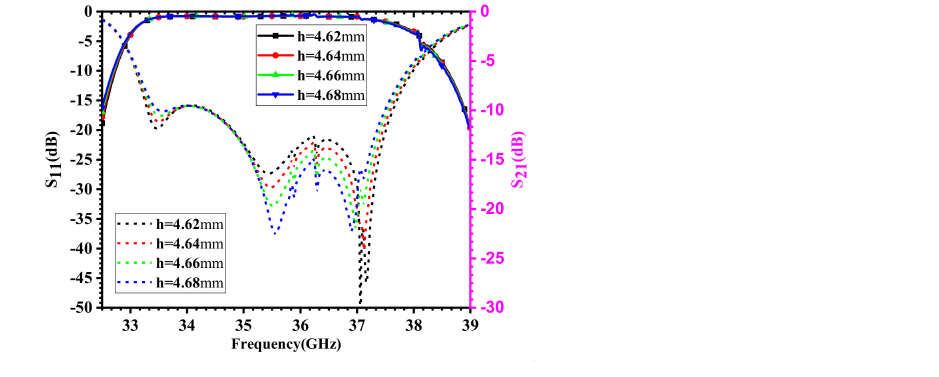
Figure 5. The influence of the coupling rectangle gap length on transmission and reflection of the input coupler.